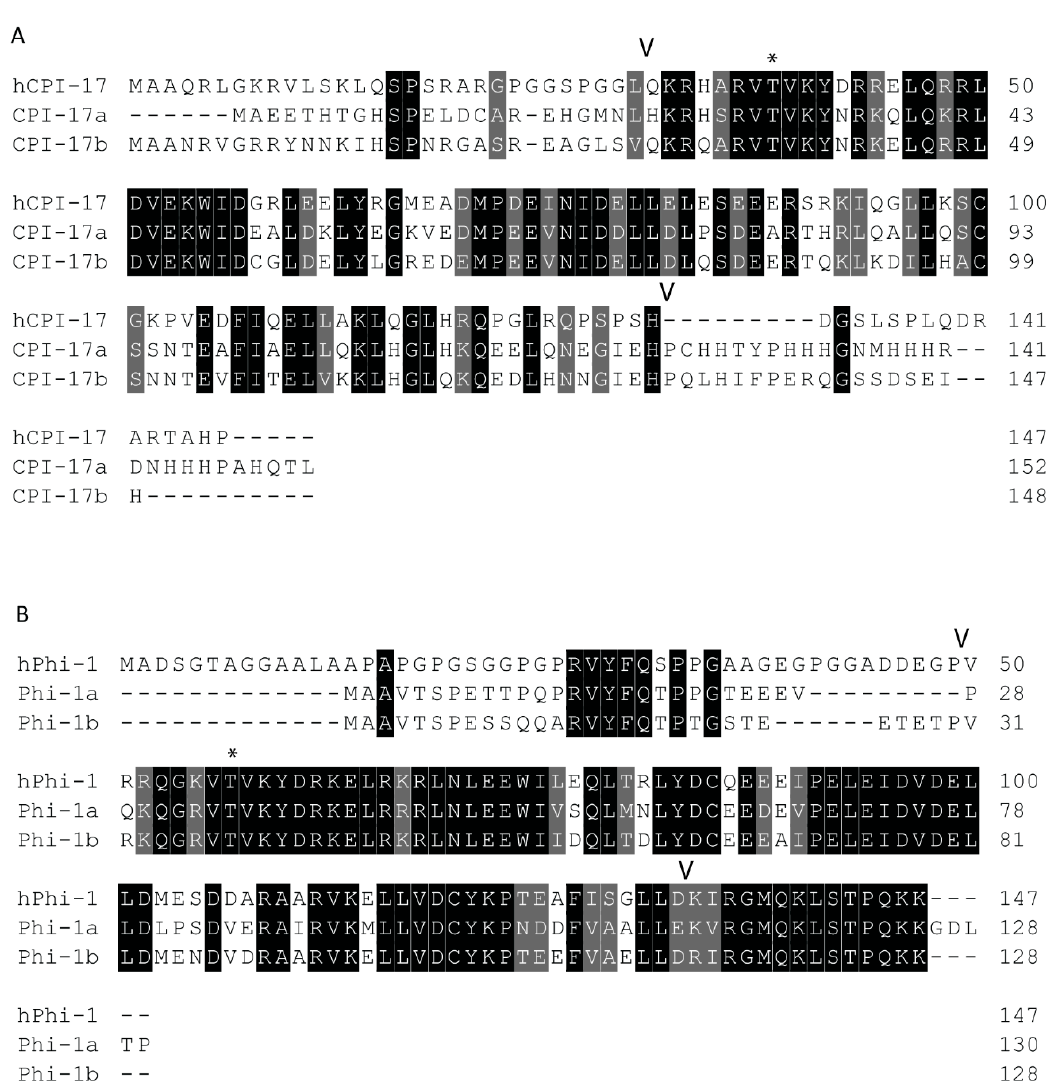
Figure 2. Protein sequences of zebrafish Cpi-17 and Phi-1 paralogs aligned to their human orthologs. ( A ). Protein alignment of zebrafish Cpi-17a and Cpi-17b with human Cpi-17. ( B ). Protein alignments of zebrafish Phi-1a and Phi-1b with human Phi-1. The conserved 86-residue long conserved PHIN domain is marked with flanking V, with inhibitory phosphorylation sites T31 (Cpi-17a), T37 (Cpi-17b), T35 (Phi-1a), and T38 (Phi-1b) indicated by *.